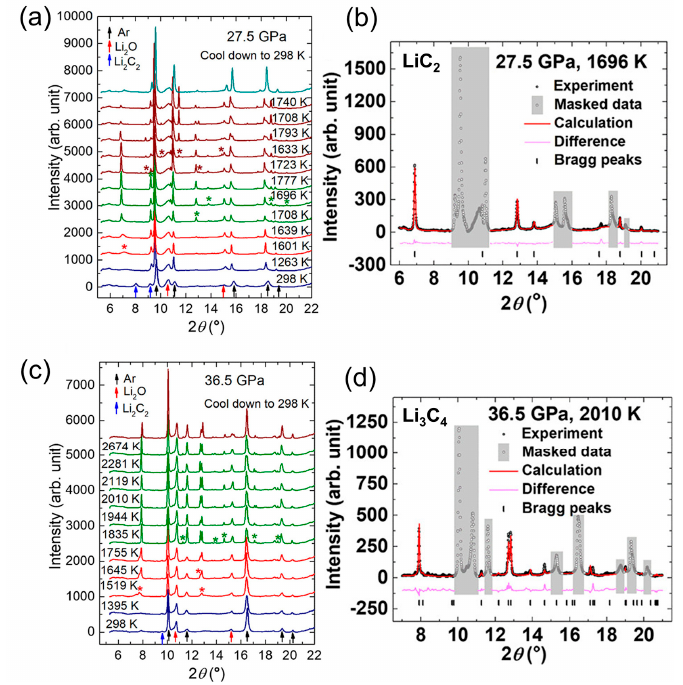
Figure 5. In situ X-ray powder diffraction (XRD) patterns of Li 2 C 2 at ( a ) 27.5 and ( c ) 36.5 GPa under high temperature [66]. Rietveld refinement plots of ( b ) LiC 2 and ( d ) Li 3 C 4 under 27.5 GPa, 1696 K and 36.5 GPa, 2010 K, respectively [66].